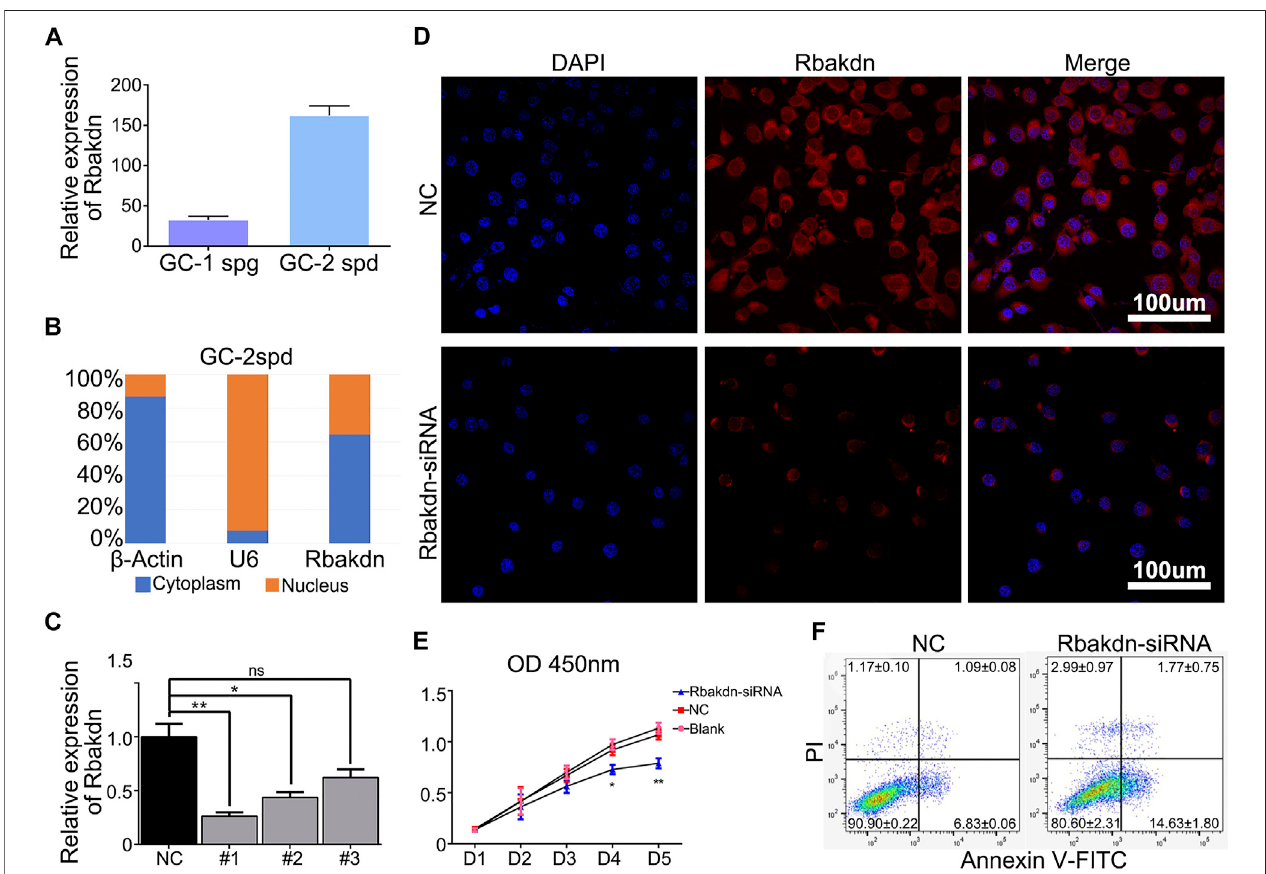
FIGURE3| KnockdownofRbakdnpromotesapoptosisofGC-2spdcells. (A) RbakdnexpressioninGC-1spgandGC-2spdcells. (B) ThedistributionofRbakdnin GC-2spd cells. β -Actin is a cytoplasmic marker, and U6 is a nuclear marker. (C) The knockdown ef fi ciency of Rbakdn-siRNA on Rbakdn in GC-2spd cells. (D) Rbakdn expression in GC-2spd cells after Rbakdn knockdown. (E) The role of Rbakdn in the proliferation of GC-2spd cells evaluated by the Cell Counting Kit-8 assay. (F) The apoptosis of GC-2spd cells after Rbakdn-siRNA treatment. The data are shown as the mean ( ± s.d.) of at least three separate experiments performed in triplicate. * p < 0.05, ** p <